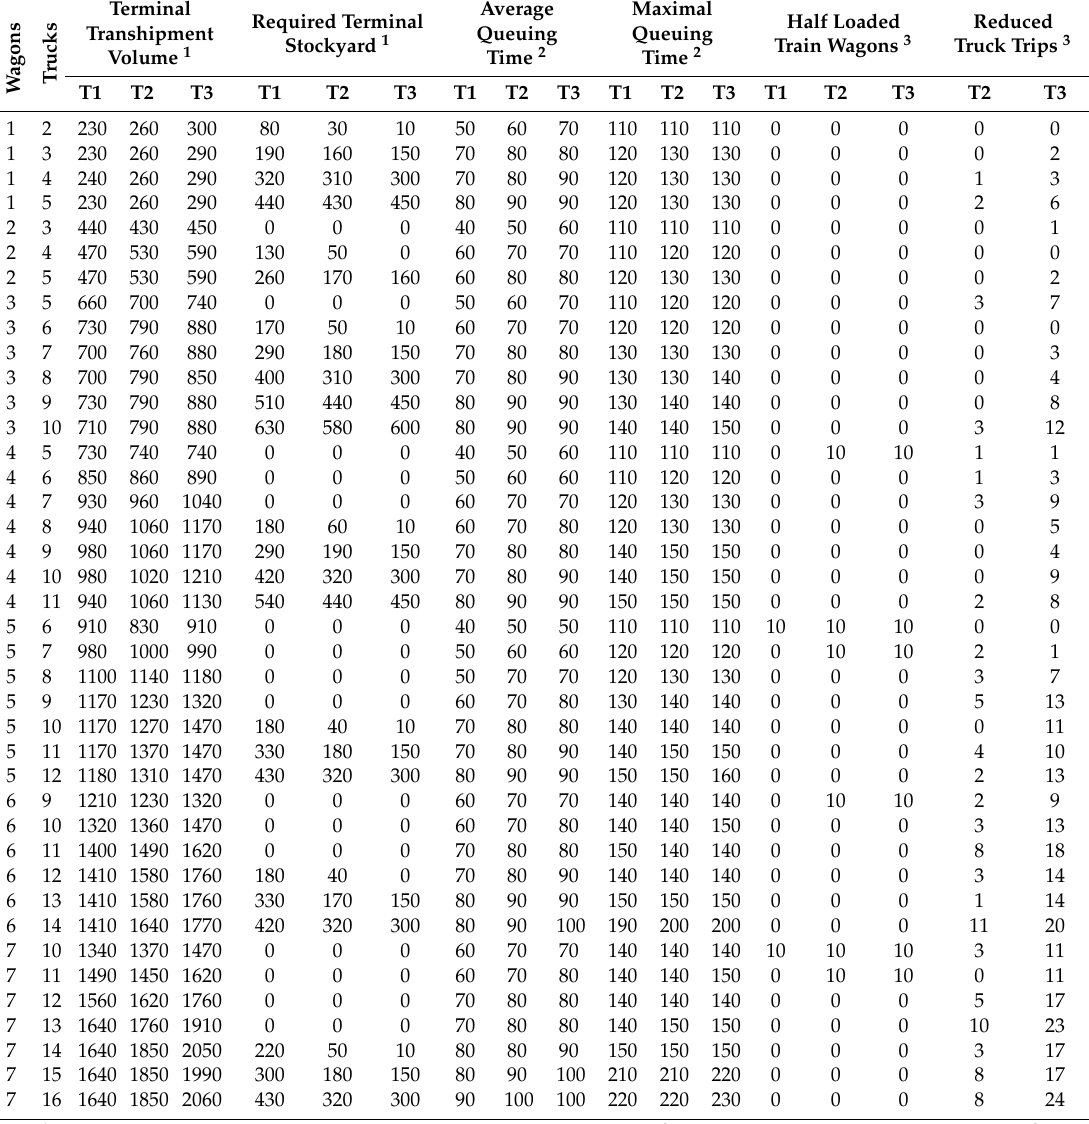
Table A3. Terminal transport template for one train pick-up, long delivery time, and all tonnages (P1D3 T1 / 2 / 3).